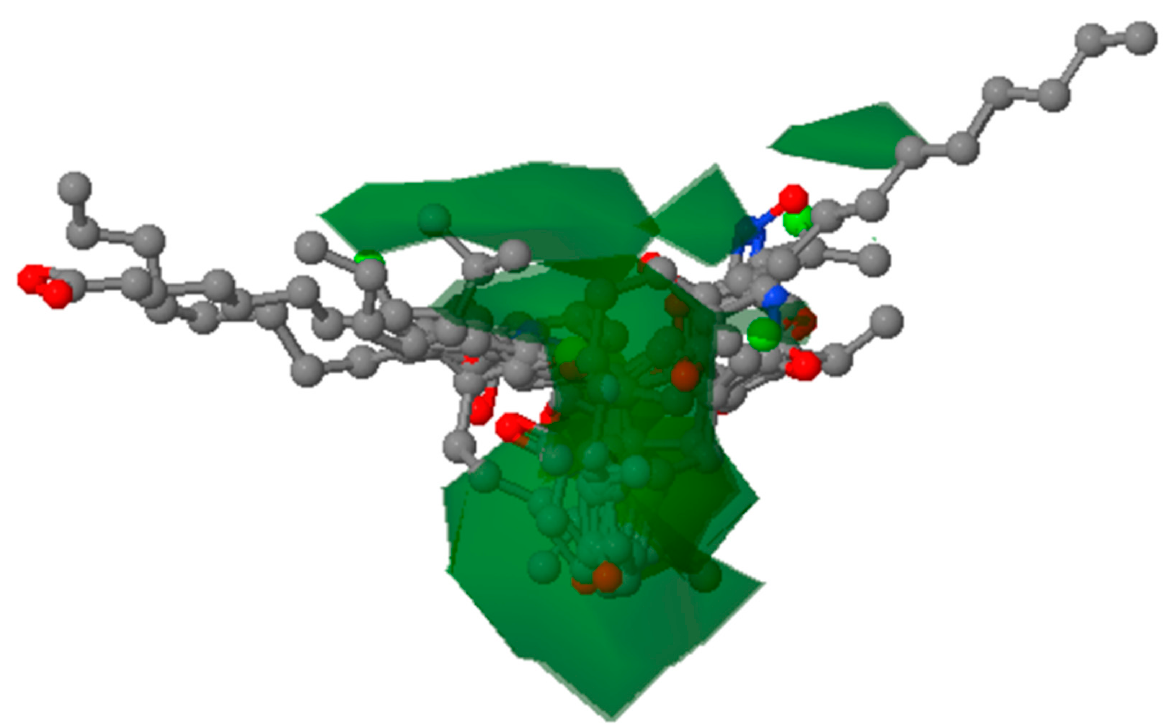
Figure 6. Contour maps of 2,2-diphenyl-1,3-benzodioxole with all conformers. The docking conformation that yielded the highest binding energy was considered for further evaluation (Figure 7).